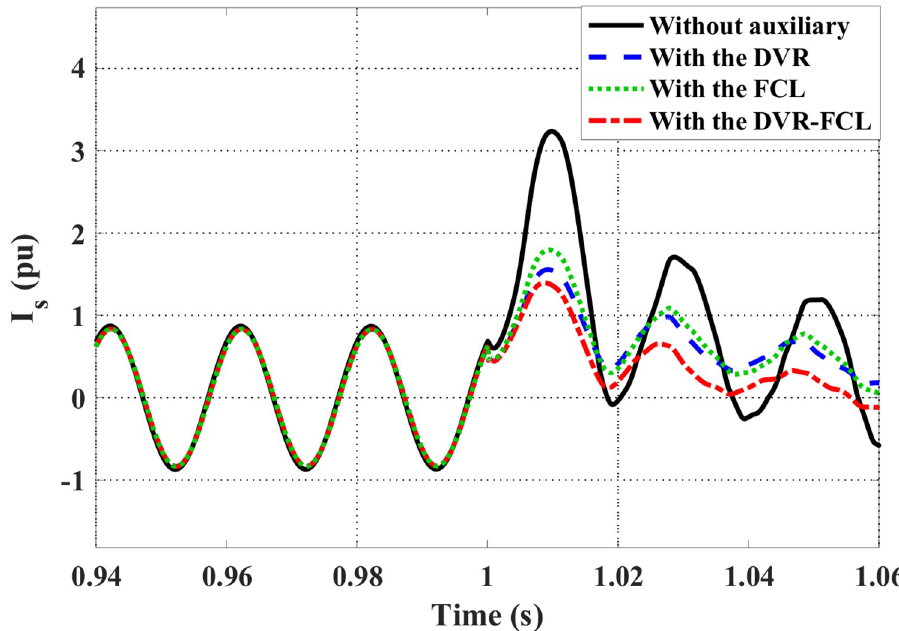
Fig 15. DFIG stator current subject to the asymmetrical fault.